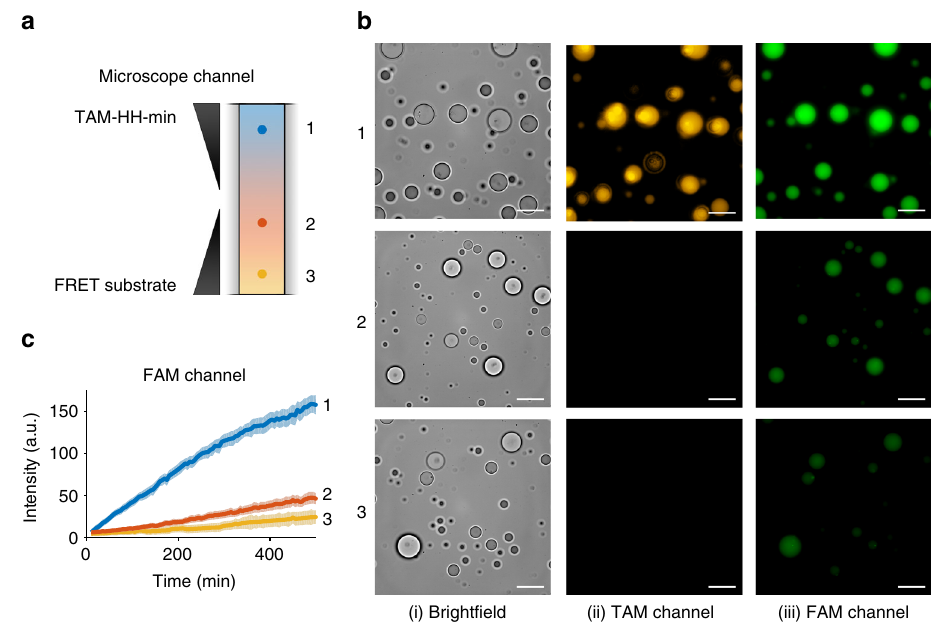
Fig. 4 Localisation and retention of RNA within coacervate droplets. a Schematic of localisation experiments where CM-Dex:PLys (4:1 fi nal molar ratio) coacervate droplets containing 0.36 μ M ( fi nal concentration) TAM-HH-min were loaded into one end of a capillary channel (1). Droplets containing 0.36 μ M FRET-substrate were loaded into the other end of the channel (3). b Wide- fi eld optical microscopy images obtained using a 100 × oil immersion lens in (i) bright fi eld and fl uorescence mode using fi lters for (ii) TAM or (iii) FAM. Images were captured in regions 1, 2 and 3 at t = 500 min (scale bar: 20 μ M). c FAM fl uorescence intensity. Shaded regions represent the standard deviation of at least seven